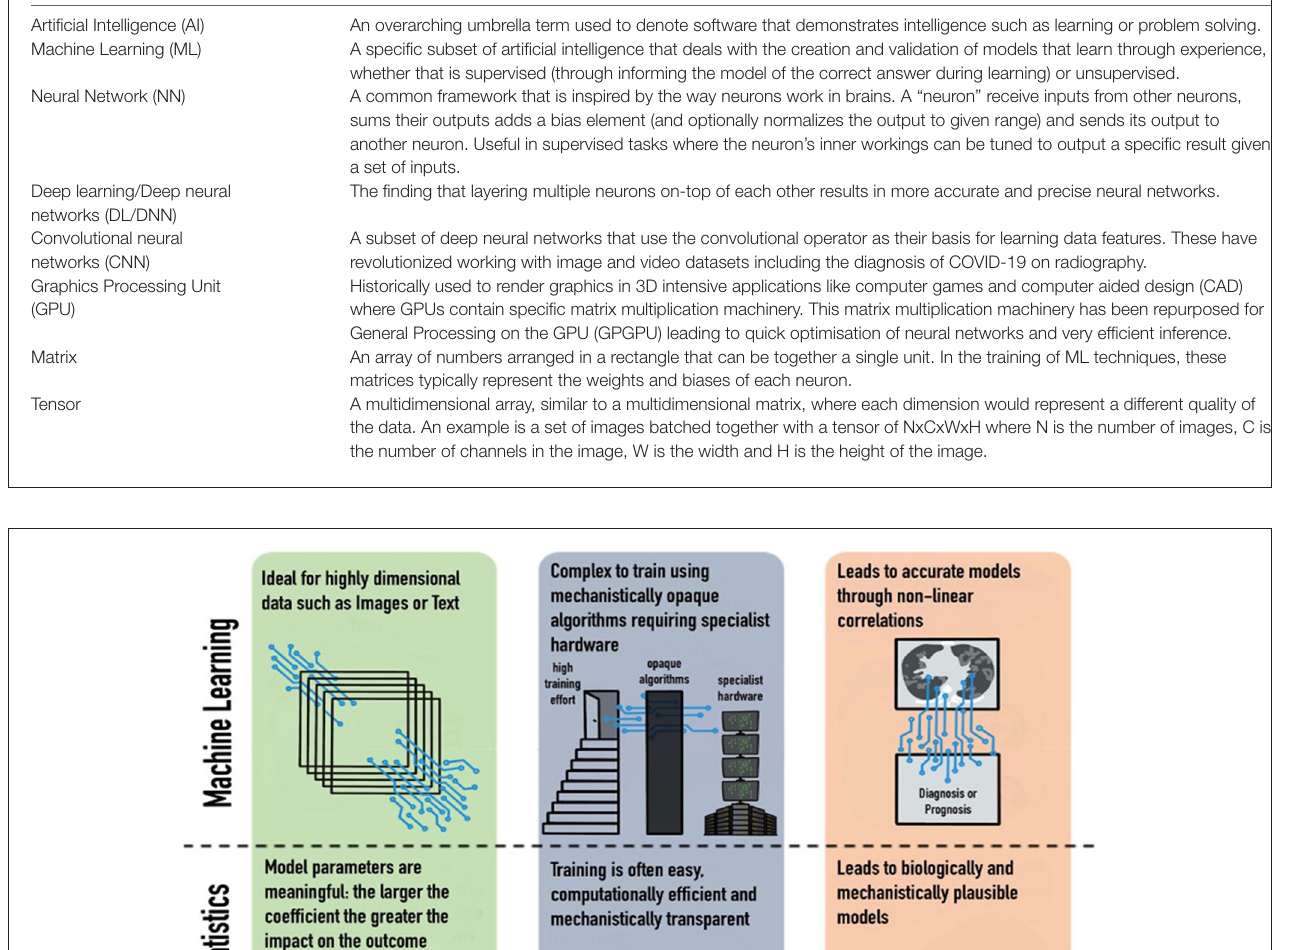
personal factors making precision, individualized,